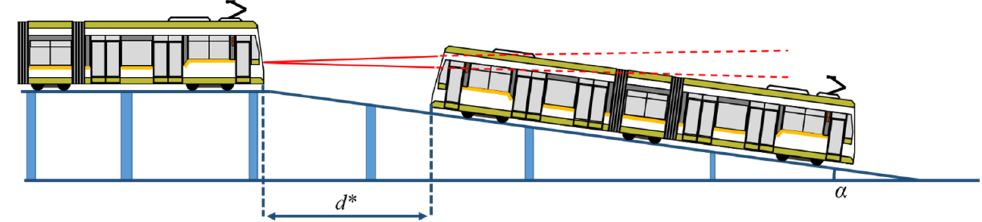
Figure 6. Downhill slope LiDAR measurement.